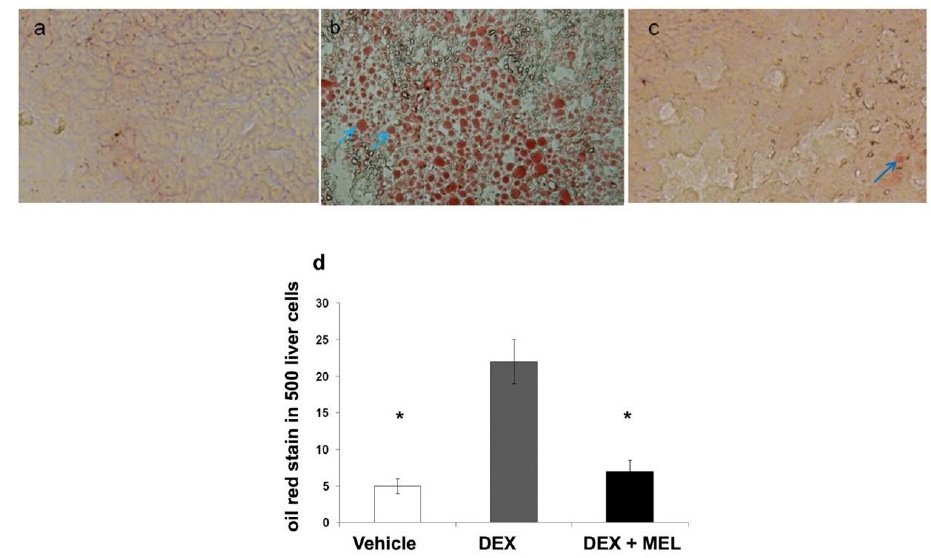
Figure 1. Liver steatosis. Oil red staining showed overexpression in the prenatal dexamethasone group (DEX) compared with that in the vehicle group. This was found to return to the control value in the prenatal dexamethasone and melatonin treatment group (DEX+MEL). ( a ) Oil red staining in the vehicle group. ( b ) The increased liver cell oil red staining in the DEX group. ( c ) The melatonin treatment decreased the number of oil red stained liver cells induced by dexamethasone at ~120 days (original magnification × 400, blue arrows: positive hepatocytes). ( d ) Semi-quantification of the oil red stained cells. All the results represent the standard error of means of six animals, * p < 0.05 when comparing with the DEX group. The letters represent different groups. DEX, prenatal dexamethasone; DEX+MEL, melatonin treatment after prenatal dexamethasone.